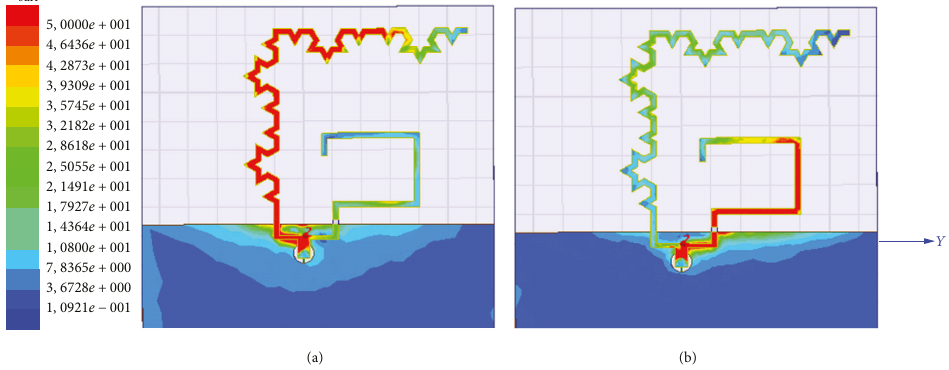
Figure 5: Current distribution of the proposed antenna at (a) 0.87GHz, (b) 1.83 GHz.